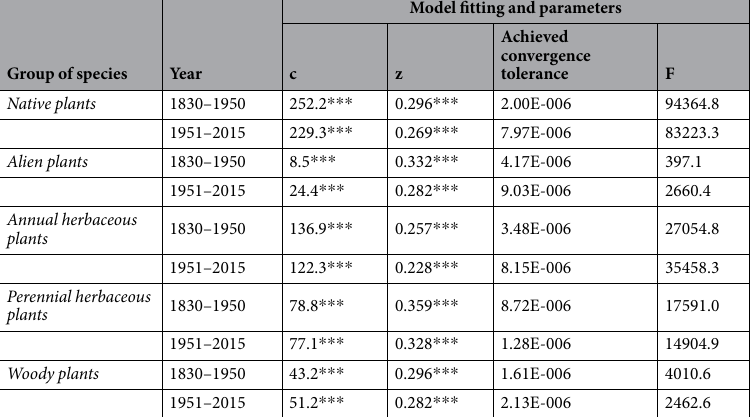
Group of species Year